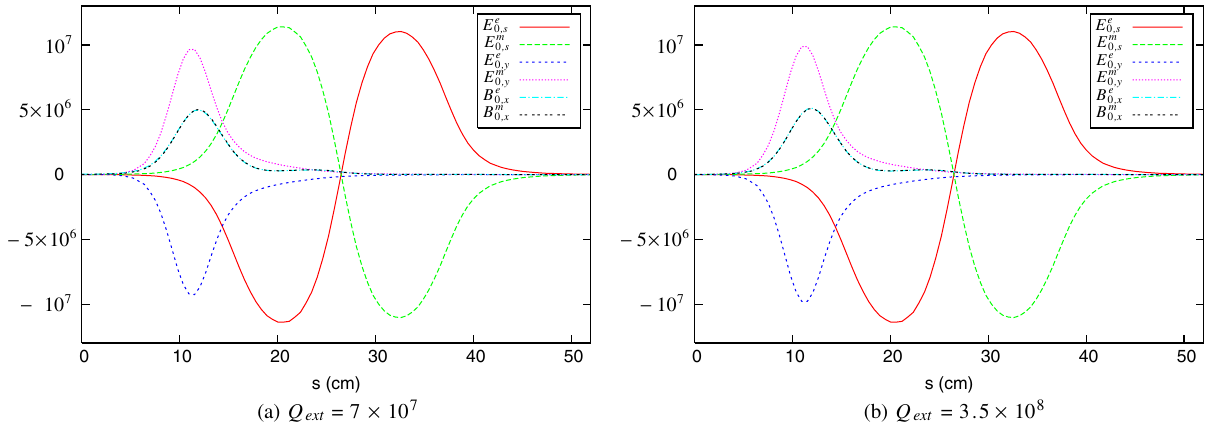
FIG. 2. (Color) Field profiles of MWS standing waves for Q and magnetic fields, respectively. E e is justified with E m